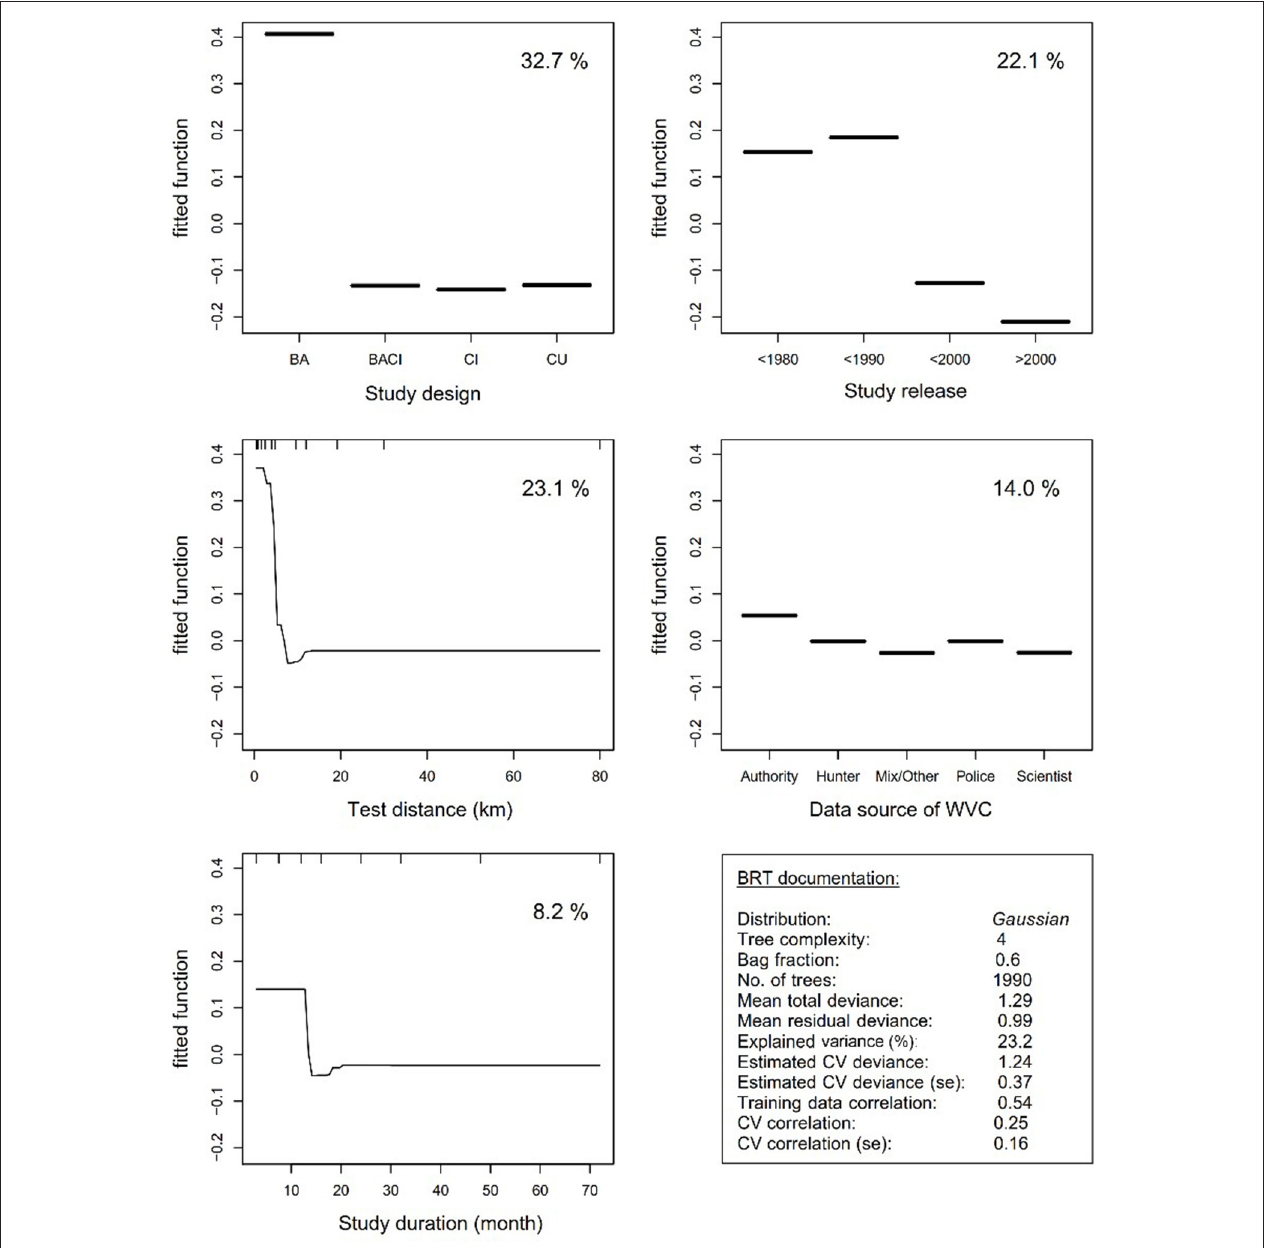
FIGURE 3 | Partial response plots of the five explanatory variables in the boosted regression tree (BRT) model including BRT documentation, such as explanatory variance of the model (23.2%), and values indicating the relative influence of the explained variance in the BRT model, for each variable respectively. Study designs included before-after (BA), before-after control-impact (BACI), control-impact (CI), and cover/uncover (CU) approaches. Data source was separated by authority from which data were obtained, i.e., transportation administration, road authorities), hunters, mix/other (i.e., more than one data source was used), police (i.e., WVC which were officially reported to the local police station) and